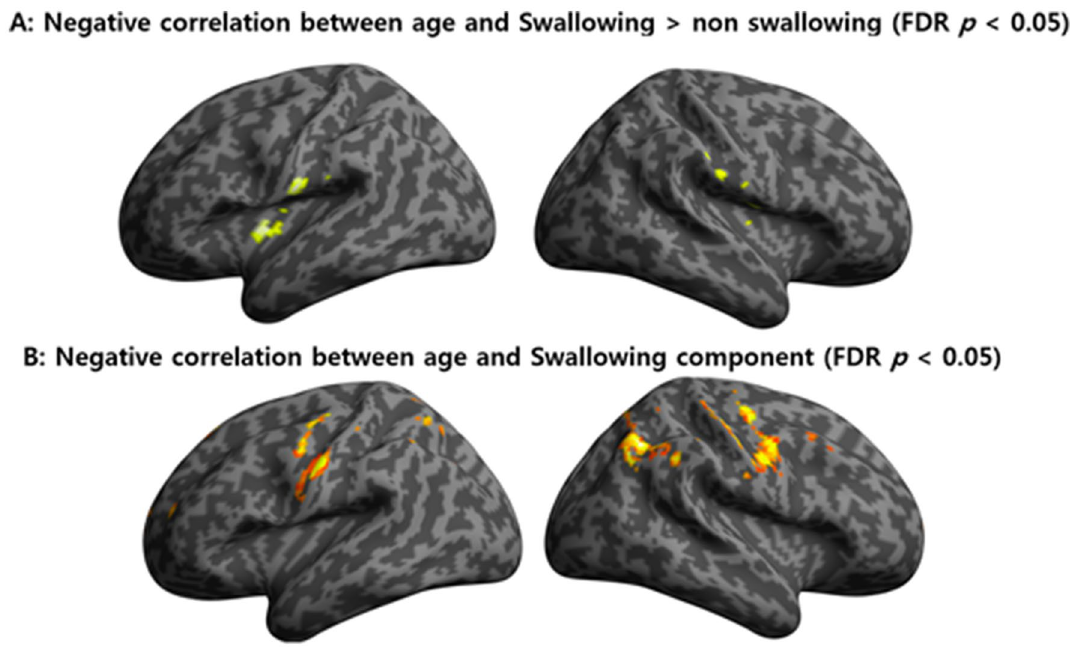
Figure 3. Negative correlation between age and BOLD signal during swallowing task. In the GLM, cognitively contrasted BOLD signals between swallowing and non-swallowing tasks showed a decline with healthy aging in both the lateral precentral gyri, postcentral gyri, and insular cortices ( A ) (r = 0.56, p < 0.001). Independent component 17, which was most positively correlated with BOLD signal (r = 0.64, p < 0.001) in the swallowing task, showed a clear negative correlation with age in both the lateral precentral gyri, postcentral gyri, and right supramarginal gyrus ( B ). BOLD, blood oxygen level-dependent; GLM, general linear model; FDR, false discovery